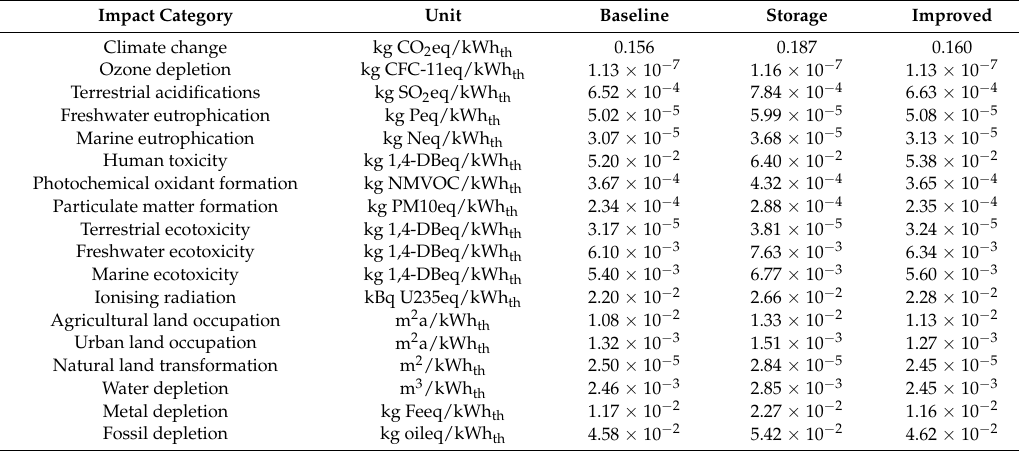
Table 7. Midpoint impact indicators per unit of thermal energy for the three